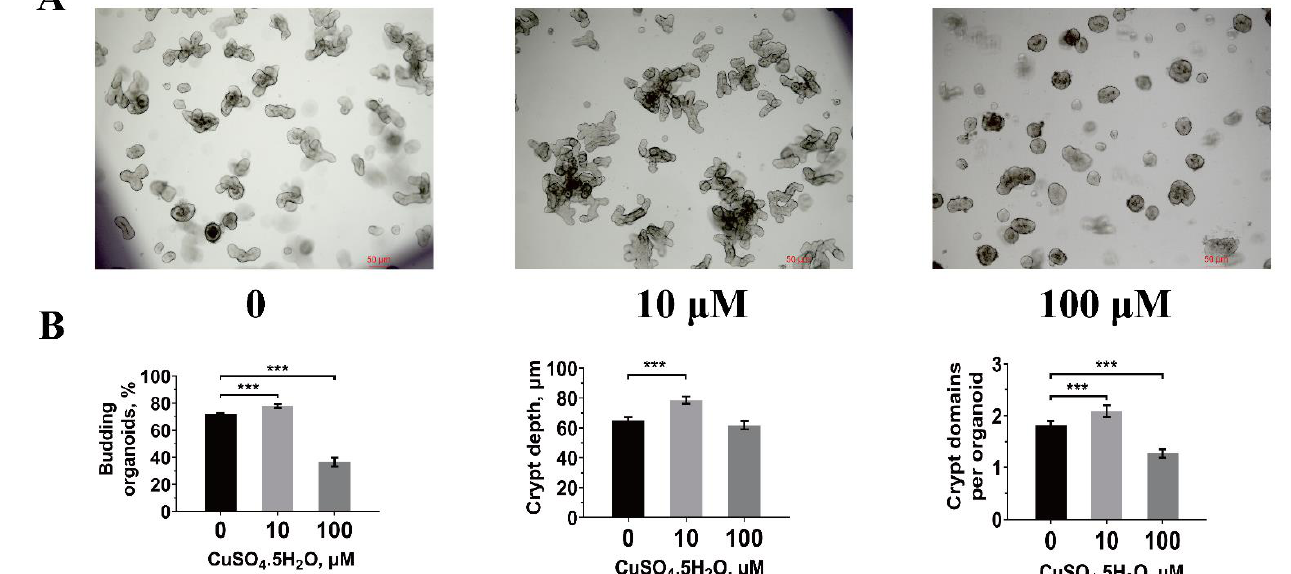
Figure 2. Effect of copper concentration on intestinal stem cells activity of piglets. ( A ) Representative images of organoid morphology after 0, 10, and 100 μmol/L CuSO 4 ·5H 2 O treatment in vitro. Scale bars, 50 μm (magnification 50×). ( B ) Organoid budding efficiency, budding crypt depth, and crypts per organoid at three days after CuSO 4 ·5H 2 O treatments were quantified. Statistical significance was determined by one-way ANOVA. The results are expressed as the means and SEM ( n = 6 wells per treatment; *** p < 0.001).